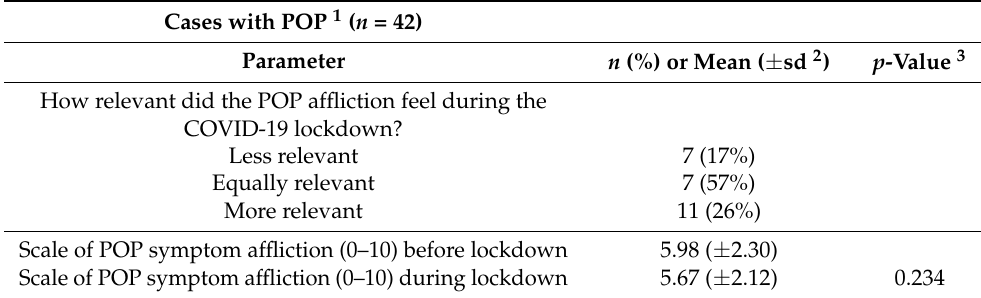
Table 4. Changes in relevance and affliction of pelvic organ prolapse symptoms during COVID- 19